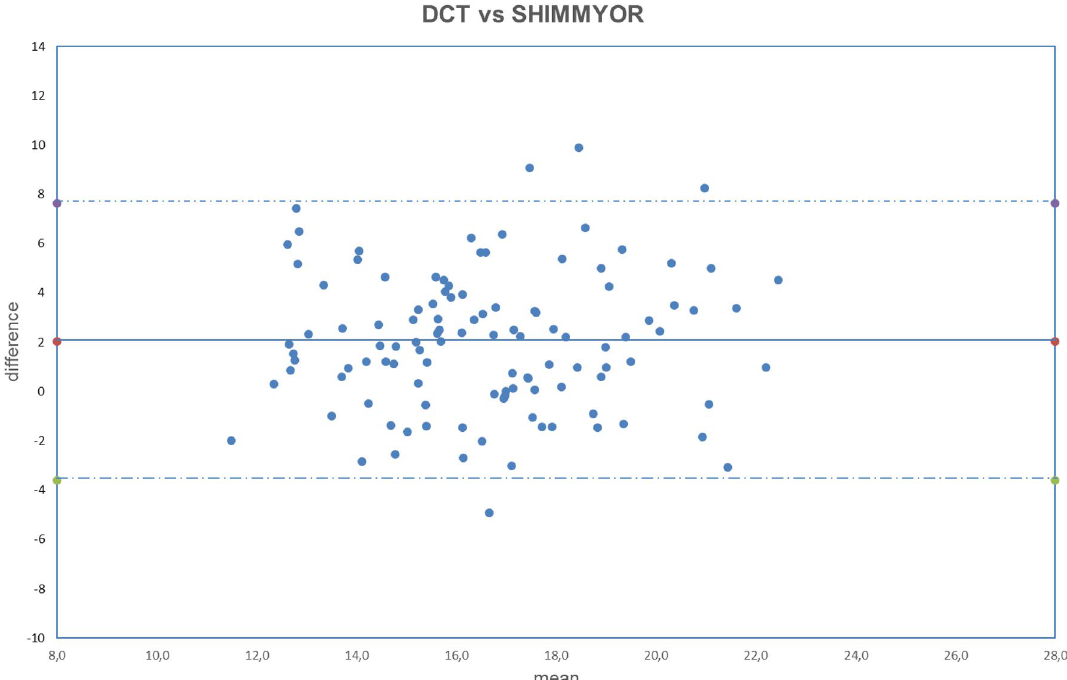
Figure 3. Bland–Altman plot between IOP measured with DCT and GAT corrected with ShimmyoR formula. Dashed line: mean difference. Dash-dotted lines: mean difference (2.02 mmHg) ± 2 standard deviation (2.80 mmHg) of the differences.